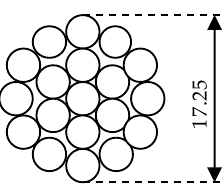
Figure 7. Section of the AAAC-Super High Conductivity (SHC) conductor with diameter 17.25 mm.